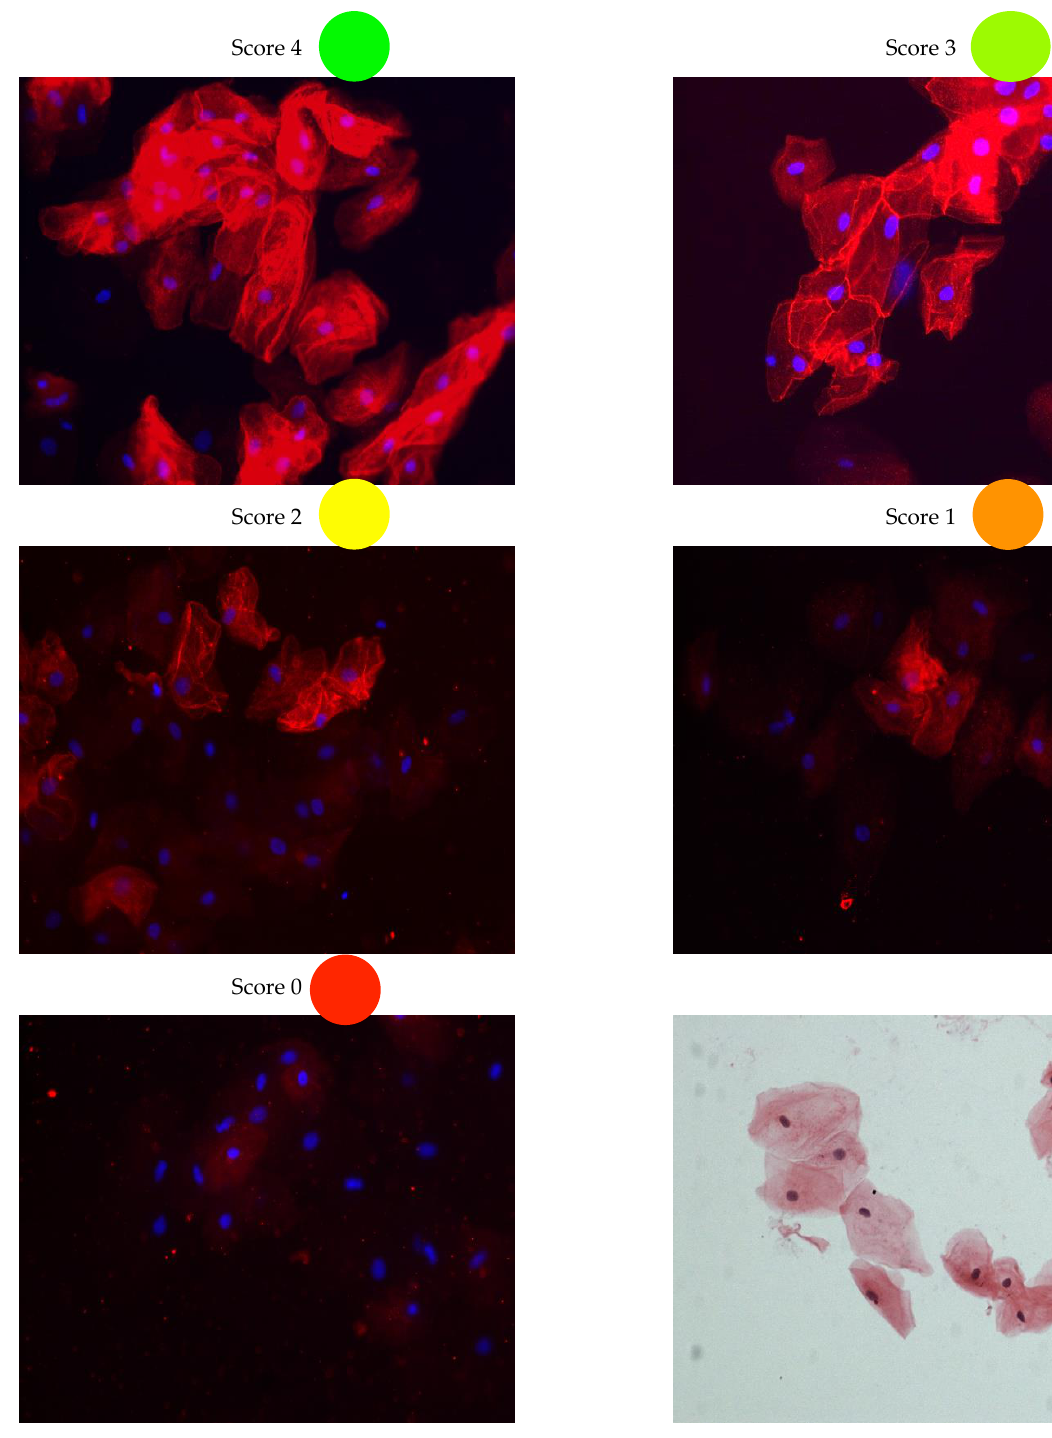
Figure 1. Examples of buccal mucosa scoring. A score of 4 means extreme strong membrane labelling and a score of 0 means no labelling at all. Scoring was performed on clusters consisting of more than three cells. Right bottom panel depicts a H&E staining of buccal mucosa cells. H&E; hematoxylin and eosin staining. 2.3. Plakoglobin Membrane Labelling in Healthy Controls Is Not Affected by Age or Sex Because of the difference in age between the controls and both the patients with, or at risk of, ACM as well as the PLN p.Arg14del patients, we investigated the potential confounding effects of age, and also sex, on plakoglobin membrane labelling in healthy controls. In all four applied dilutions, scores of plakoglobin labelling did not differ